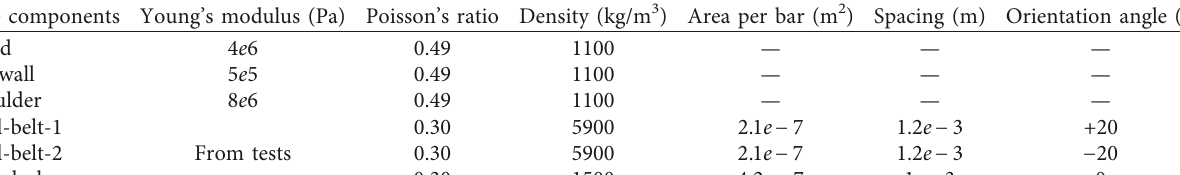
Table 3: Material parameter characteristics of each component of the tire.